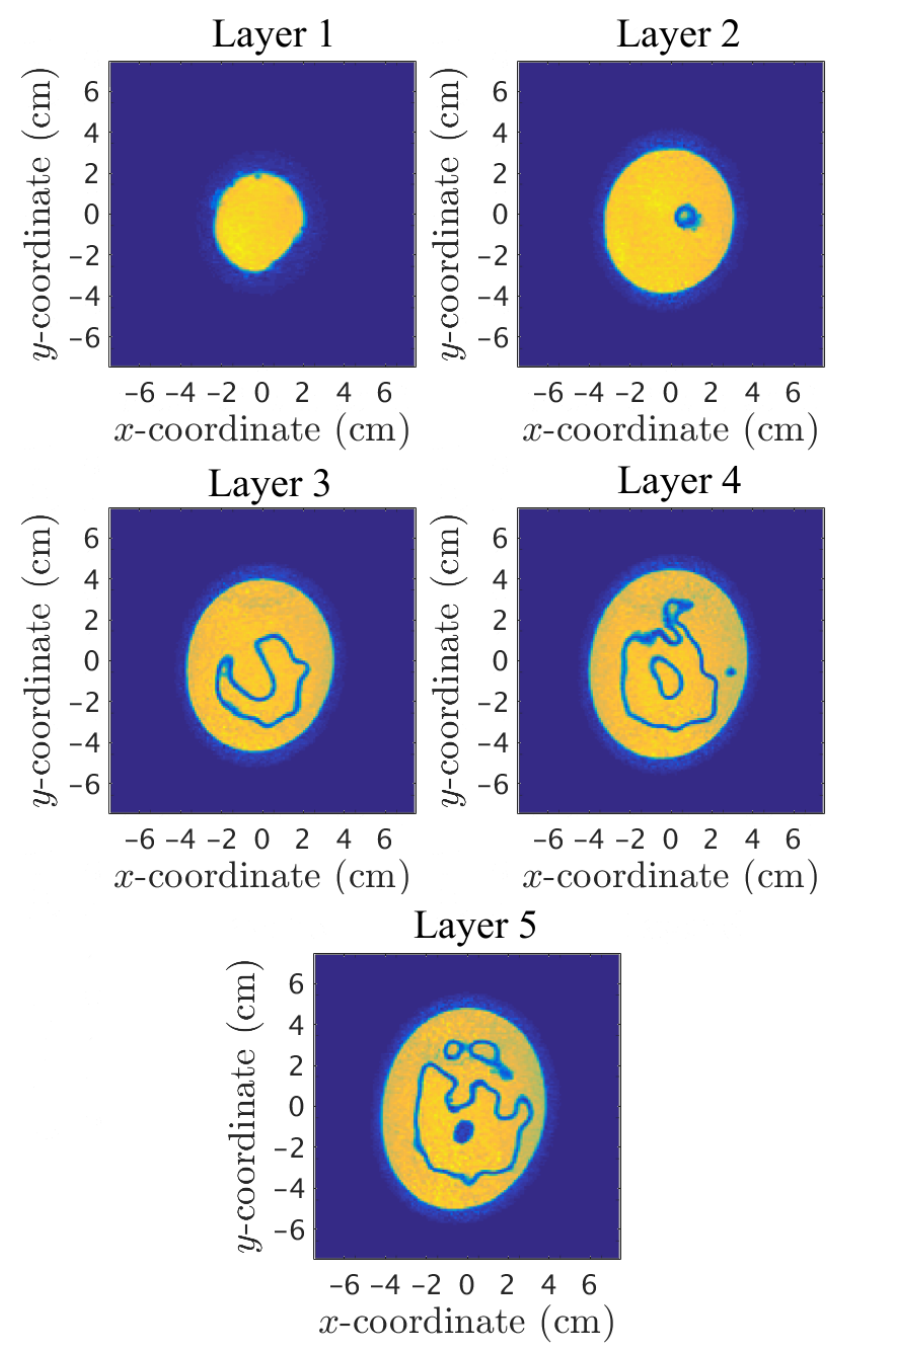
Figure 10. MRI scans of the five imaging